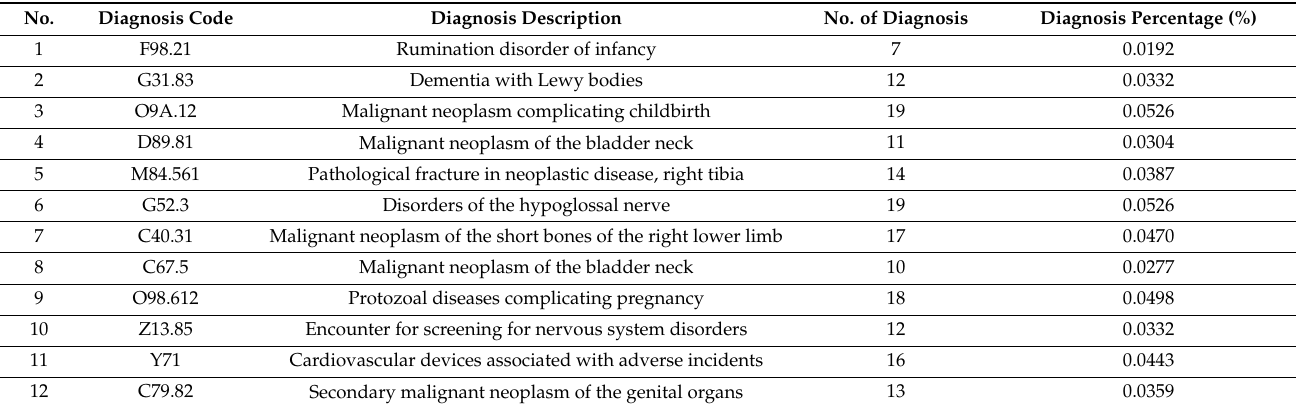
Table 9. Summary of various diagnostic